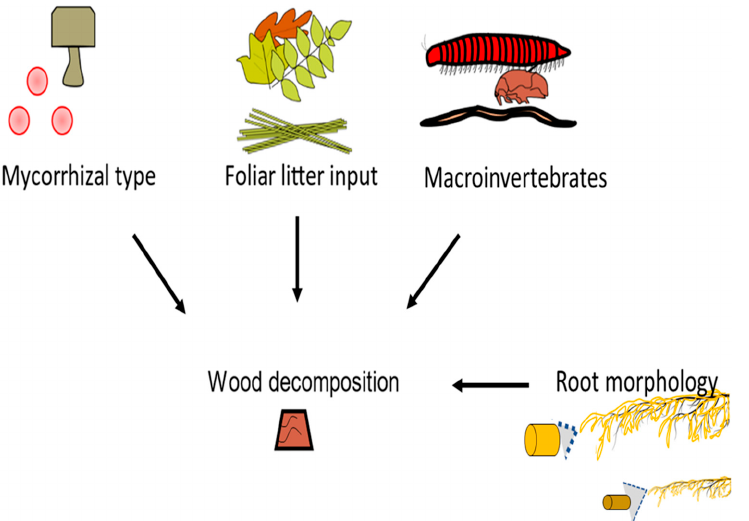
Figure 1. Testing the effects of mycorrhizal type, foliar litter input, root morphology, and macroinvertebrates on wood decomposition in the root zone of 13 temperate trees.